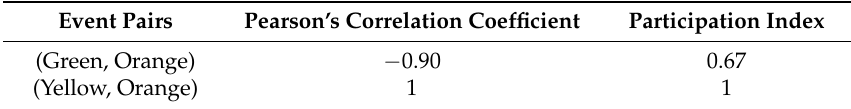
Table A1. Pearson’s correlation coefficient and participation index for two event pairs.